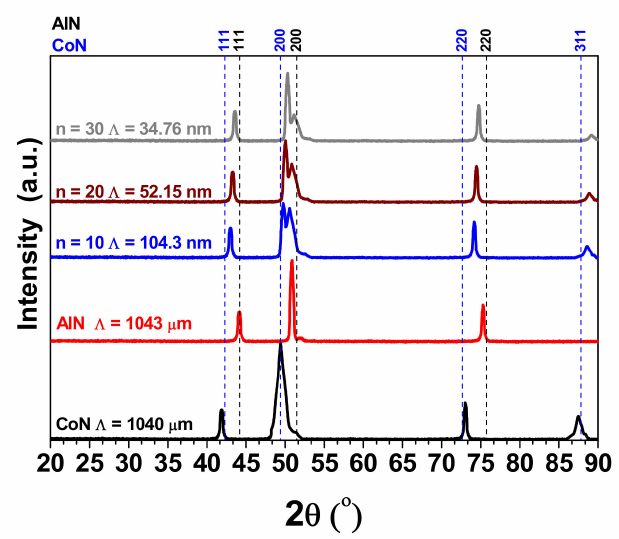
Figure 2. Diffractograms of the AlN and CoN single layer and [AlN/CoN]n multilayer coatings with different number of bilayers (n = 10, 20, 30). The dotted lines indicate the position of the peaks obtained from international index files